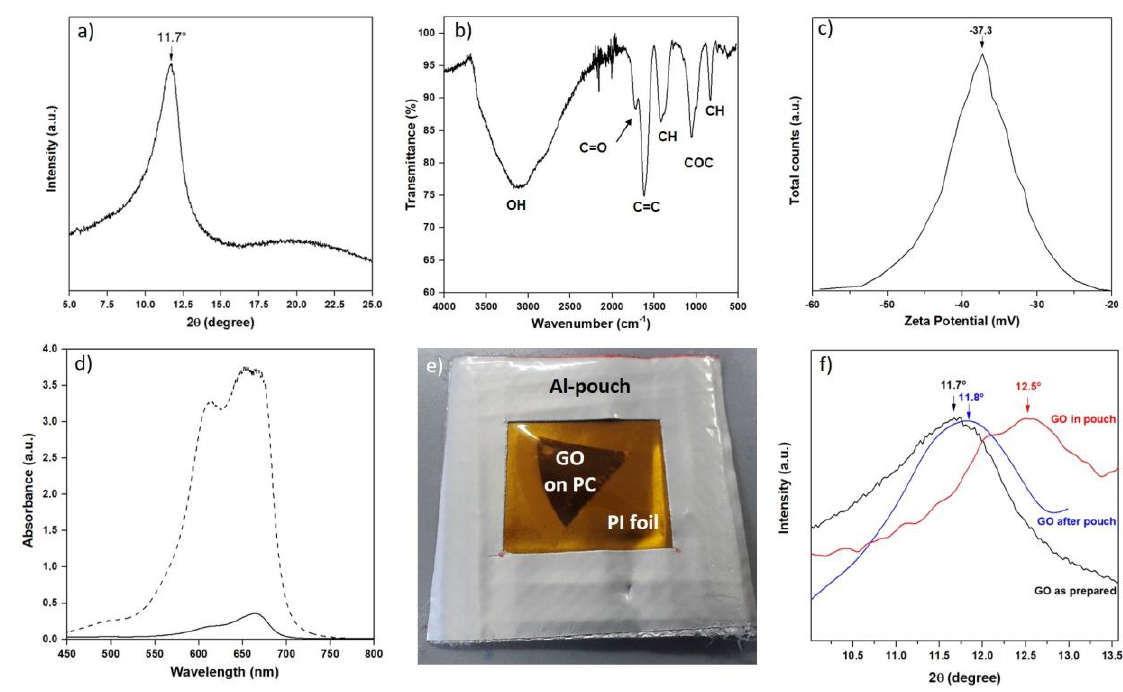
Figure 3. ( a ) XRD spectrum of GO membrane: the peak linked to interlayer distance is located at 11.70 degrees (d = 7.56 Å). ( b ) FTIR spectrum of GO membrane. ( c ) Z-potential measurement in GO solution. ( d ) UV-Vis spectrum of methylene blue (MB) solution before adsorption (dashed) and after adsorption (continuous) by GO membrane. ( e ) Digital image of the polyimide-modified Al-pouch containing a piece of dry GO membrane. ( f ) XRD spectra showing the evolution of the GO interlayer peak before, during, and after sealing in the pouch (see Figure S6 for further